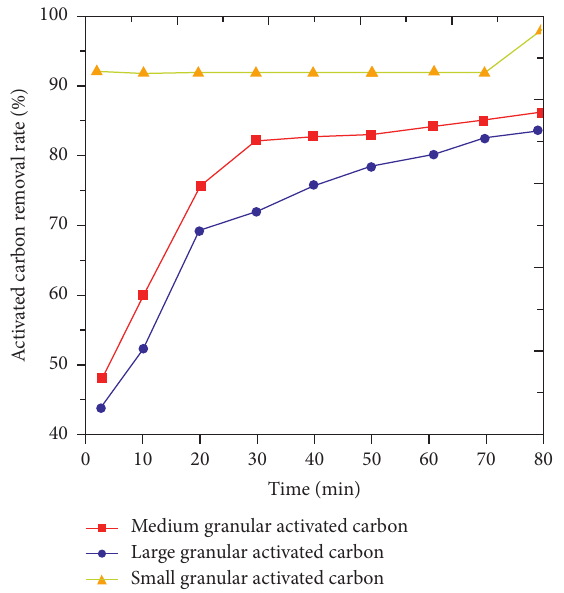
Figure 5: Removal rate of activated carbon at different